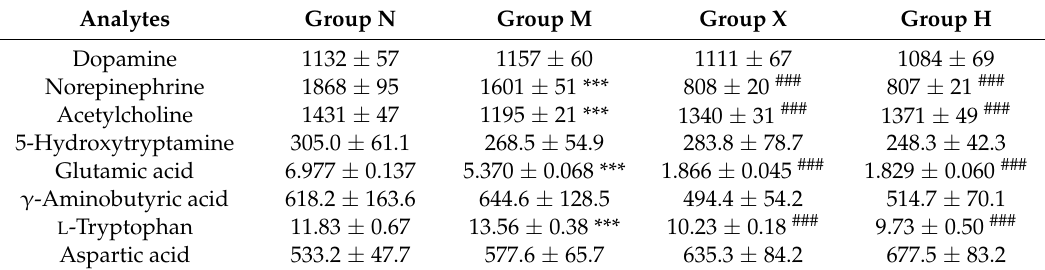
Table 4. Mean concentration (ng · mg − 1 ) of the analytes in rat brain in the four experimental groups (mean ± SD, n =